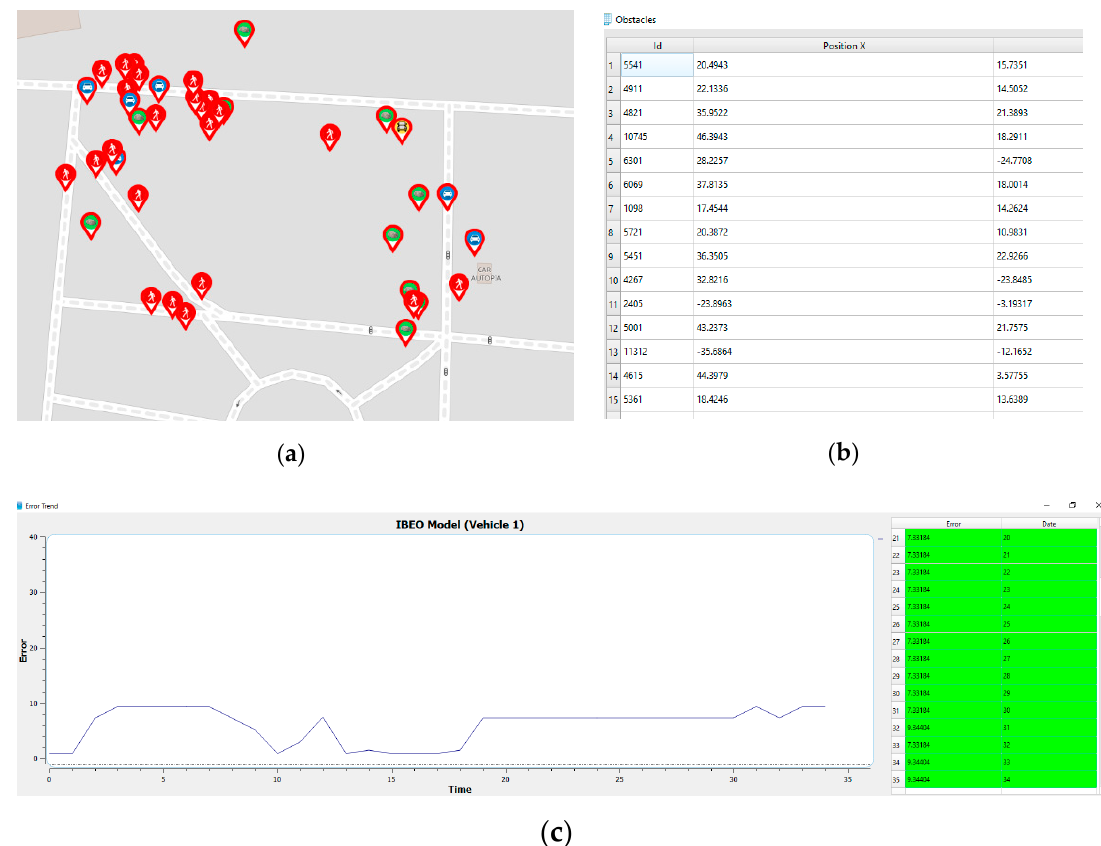
Figure 6. ( a ) Collaborative mapping; ( b ) obstacles detected in the database; ( c ) LiDAR data for run-time accuracy error detection.